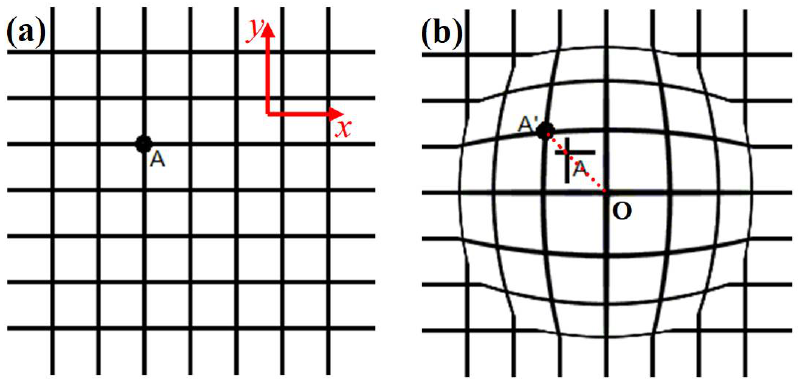
Figure 1. Image spherizing: ( a ) initial image; ( b ) spherized image.